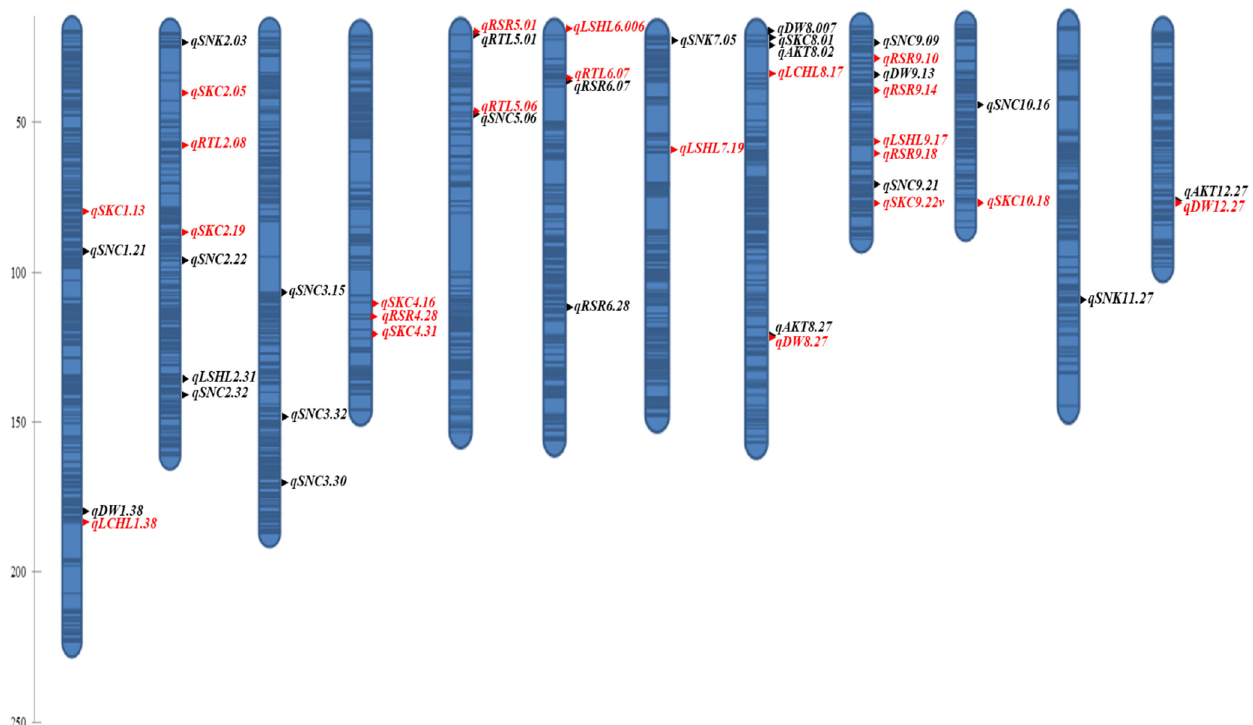
Figure 4. Positions of the QTLs on the linkage map for alkalinity tolerance traits in the Cocodrie × Dular RIL population. Red and blue fonts represent Cocodrie and Dular alleles for the increased means, respectively. Dark regions on the genetic map are the marker saturated regions and light regions represent gaps between the markers .